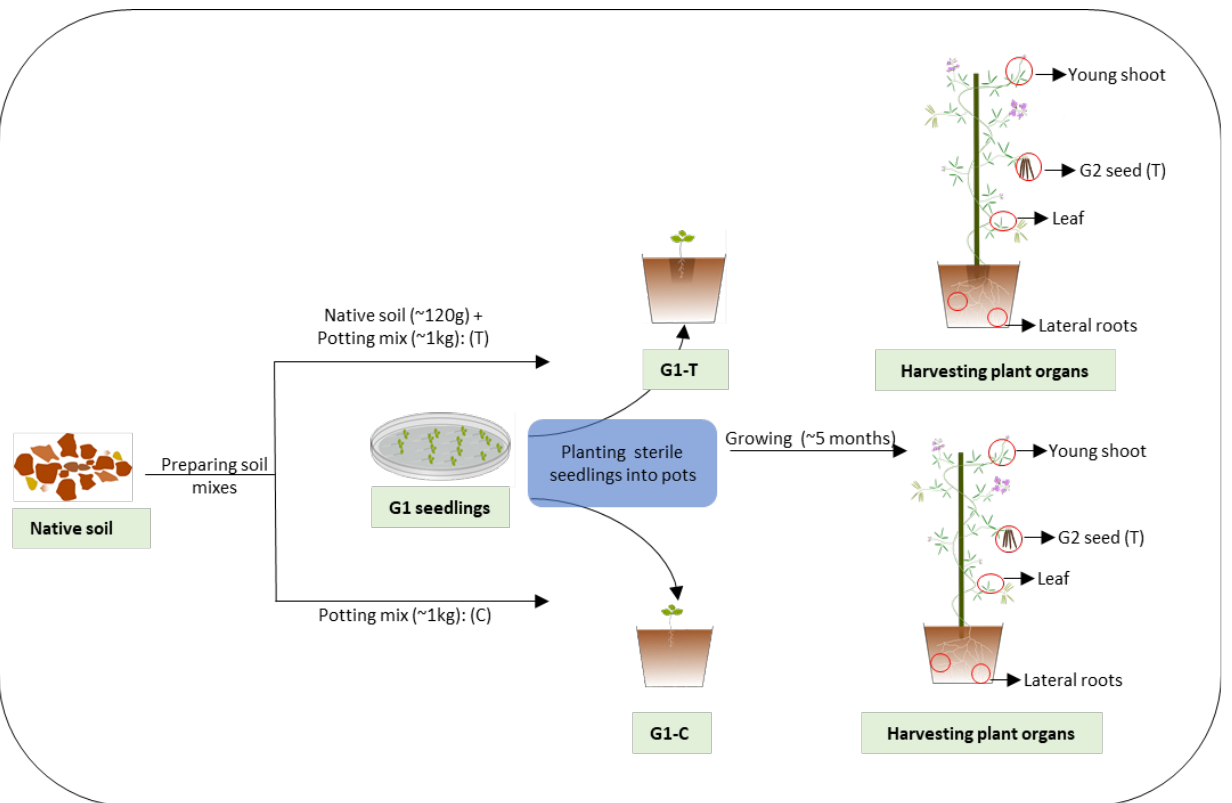
Figure 1. Schematic representation of the greenhouse experimental set up.